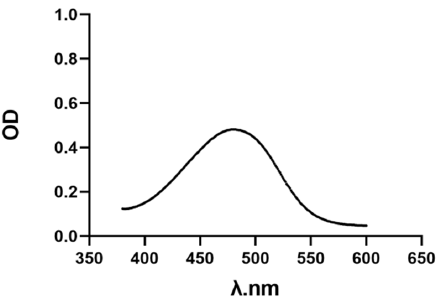
Figure 1. UV-V is spectrum of AST. The absorbance curve of AST was detected by step 2 nm, and the Figure 1. UV ‐ Vis spectrum of AST. The absorbance curve of AST was detected by step 2 nm, and maximum absorption wavelength was found at 480 the maximum absorption wavelength was found at 480 nm.